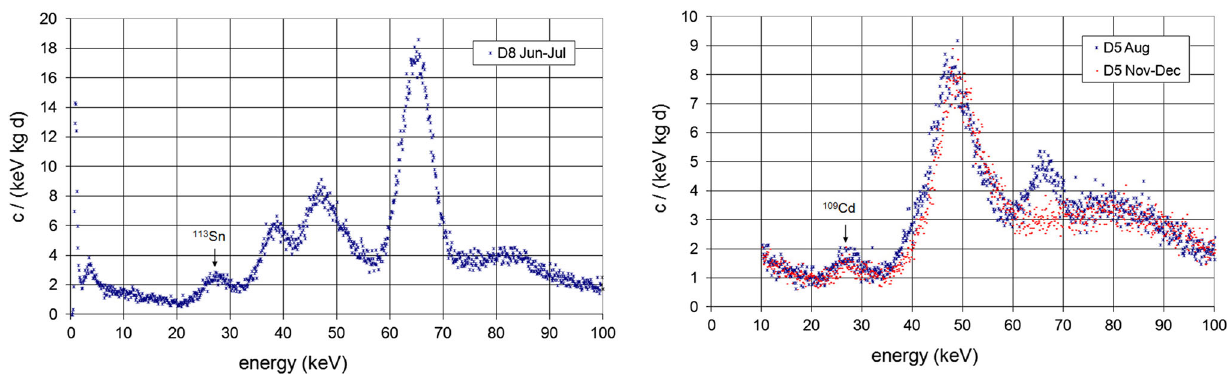
Fig. 4 Examples of the energy spectra considered in the quantifica- tion of 113 Sn and 109 Cd signals from the ANAIS-112 data: spectrum of D8 detector taken during June-July 2017 after being ∼ 4 months under- ground used for 113 Sn (left) and those of D5 detector during August and November-December in 2017 after ∼ 9 and 12 months underground